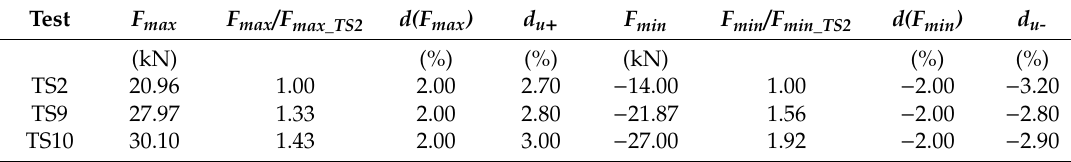
Table 1. Comparison of seismic performances of investigated specimens.